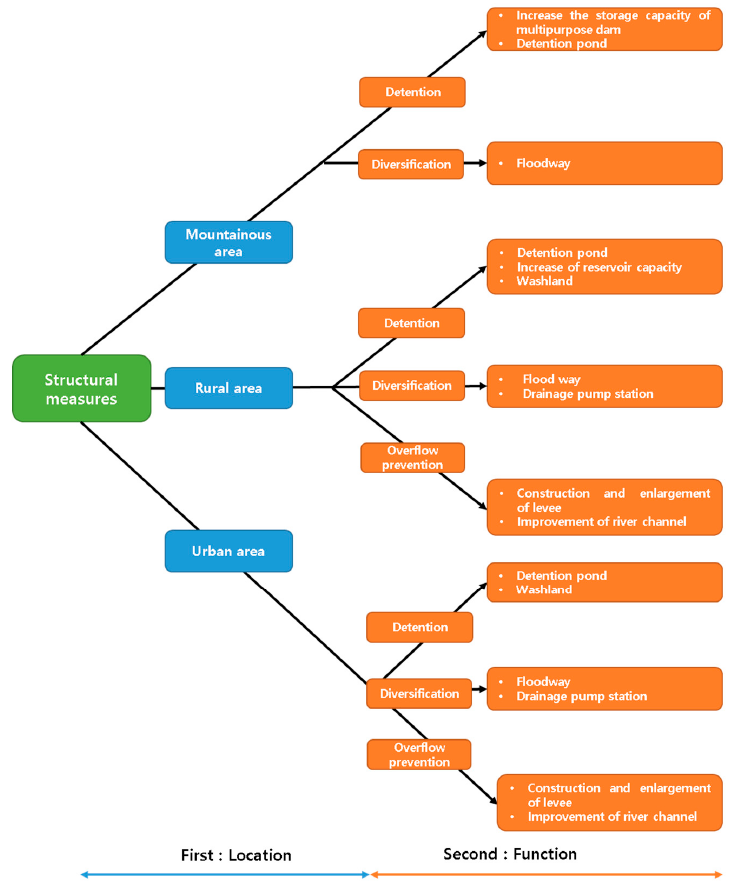
Figure 2. Classification model of structural measures.